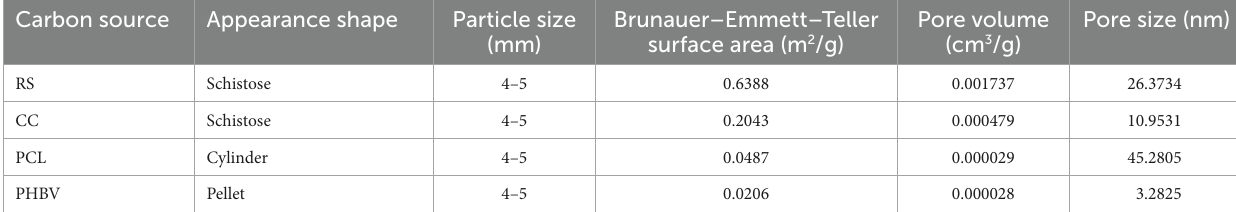
TABLE 1 The physical properties of the four types of carbon sources. Carbon